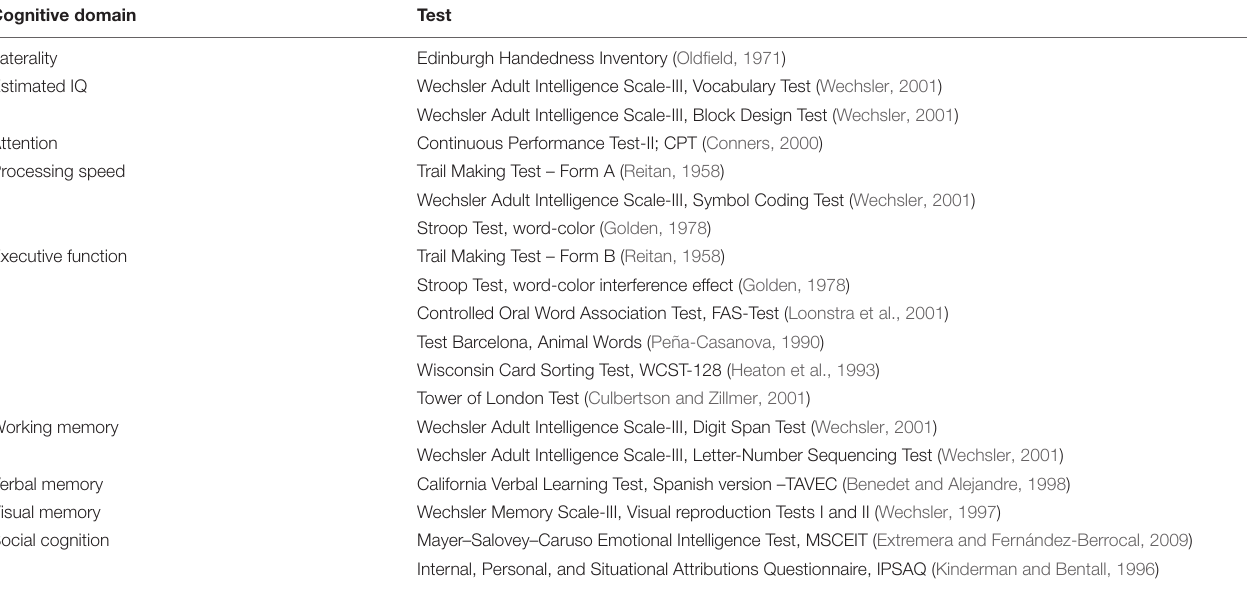
TABLE 2 | Neuropsychological Test Battery.